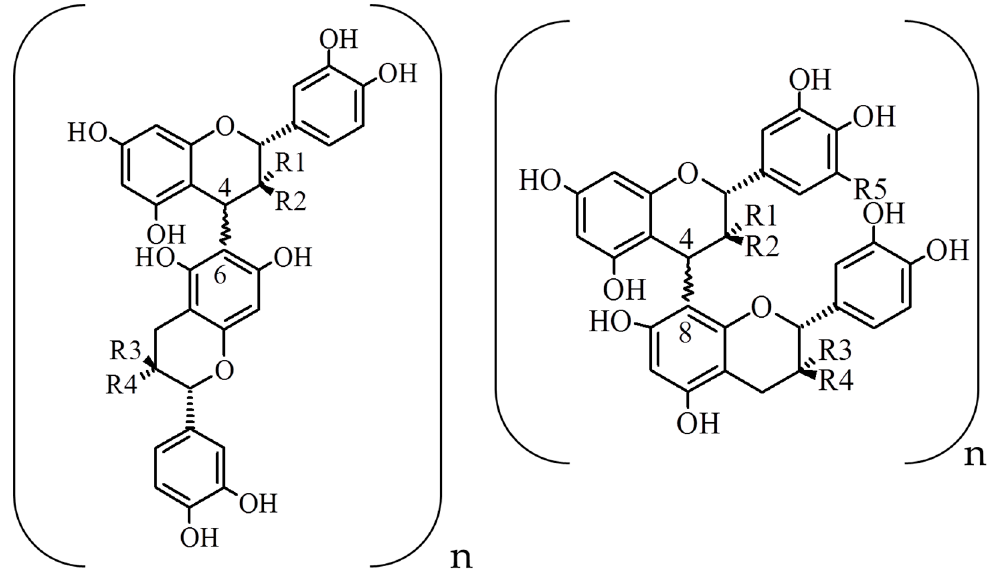
Figure 1. Structural presentation of B-type proanthocyanidin units.